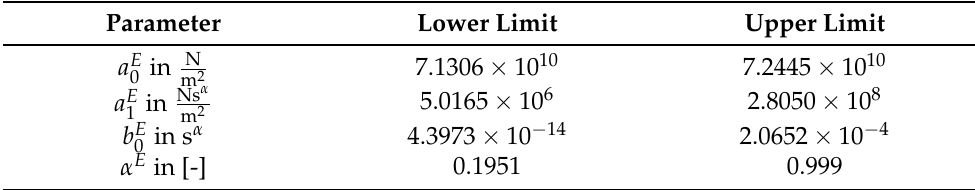
Table 10. Limit values after curve fit.